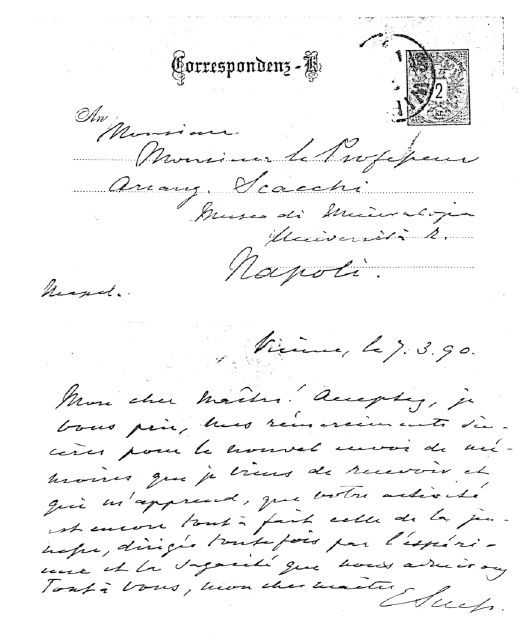
Fig. 1. Letters from Edward Suess to Scacchi, Vien- na, 7 March 1890, Biblioteca Fondazione Pomarici Santomasi, Gravina in Puglia (Bari, Italia), Cart. Scacchi, B4, F 11, N